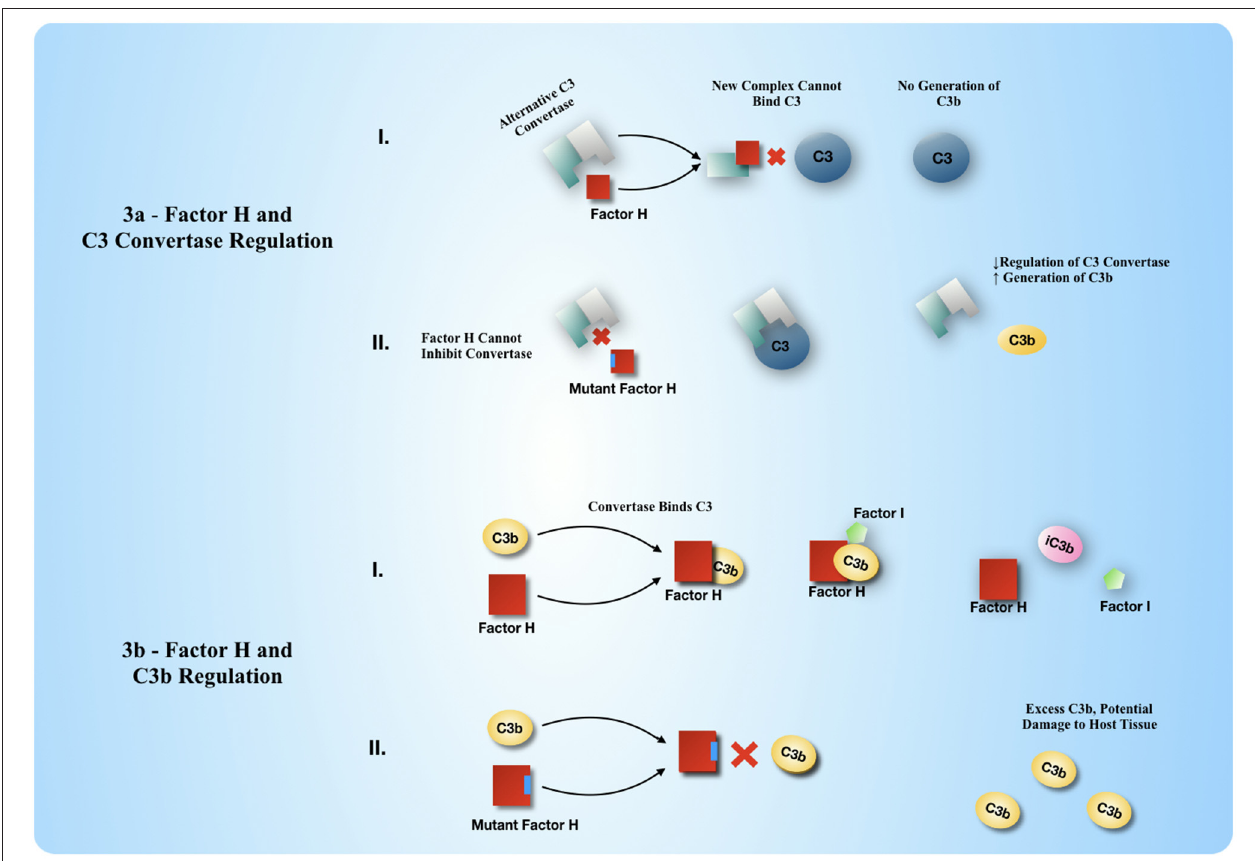
FIGURE 3 | Factor H regulates the generation of C3b and the inactivation of C3b. (a) Factor H regulates the generation of C3b by active disassembly of the C3 convertase enzyme. Factor H displaces the Bb binding partner to C3b to make a new complex with C3b that is Factor H: C3b, hence ceasing further generation of C3b. (b) Factor H regulates the level of C3b by participating in further enzymatic degradation of C3b to iC3b and other smaller protein fragments. Factor H acts as a cofactor to Factor I to bring C3b and Factor I together so that factor I may degrade C3b further through proteolysis. iC3b and smaller fragments of C3 can no longer be a part of any C3 convertase assembly, either on a cell surface or as a soluble enzyme in